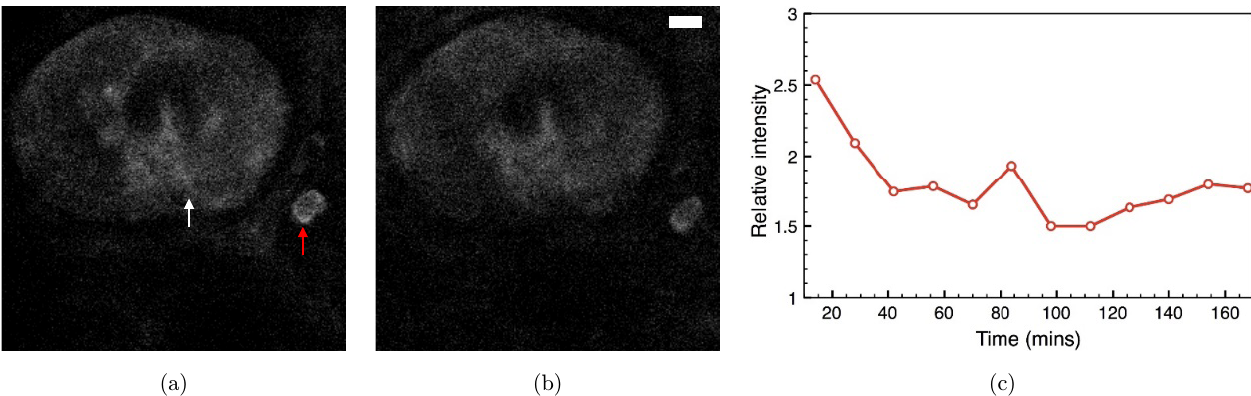
Fig. 3. In vivo mast cell degranulation process (a) image right 14 min post UVB illumination, (b) 100 min post UVB illumination and (c) individual granule °uorescence intensity count. (Bar: 20 (cid:4) m).